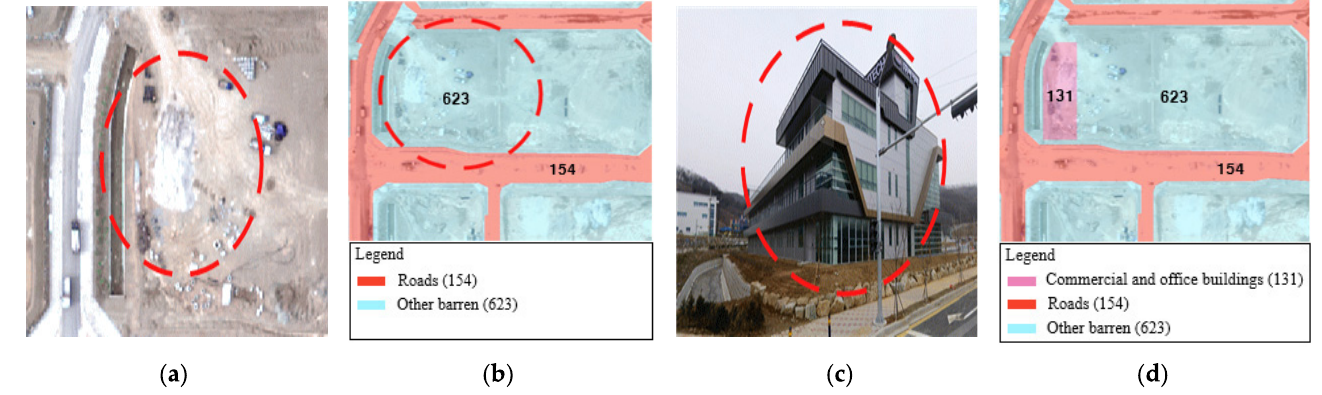
Figure 4. Example results of the second detailed landcover map update process, ( a ) Aerial photo; ( b ) After first update; ( c ) Field survey photo; ( d ) After second